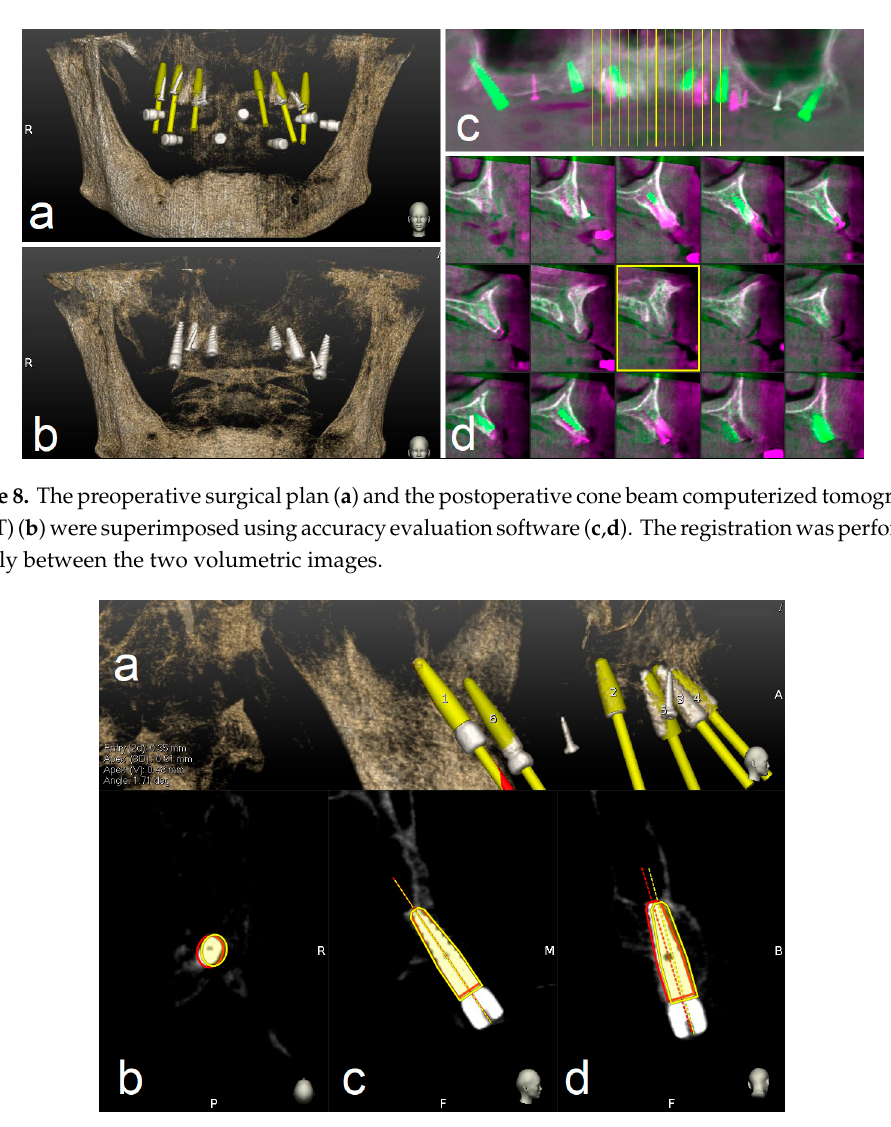
Figure 9. The software automatically fits an implant model to its appearance in the post-operative image ( a ) and computes the angular axis corrected between the planned and actual implant locations (implant inserted with dynamic guidance) ( b – d ).